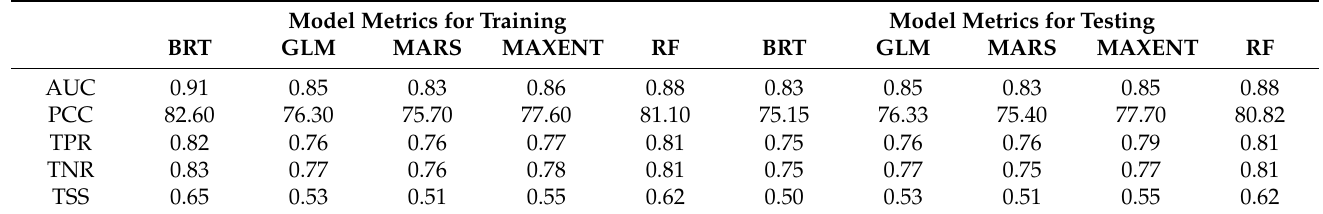
Table 3. Values of the metrics for training and testing and for each model. Model Metrics for Training